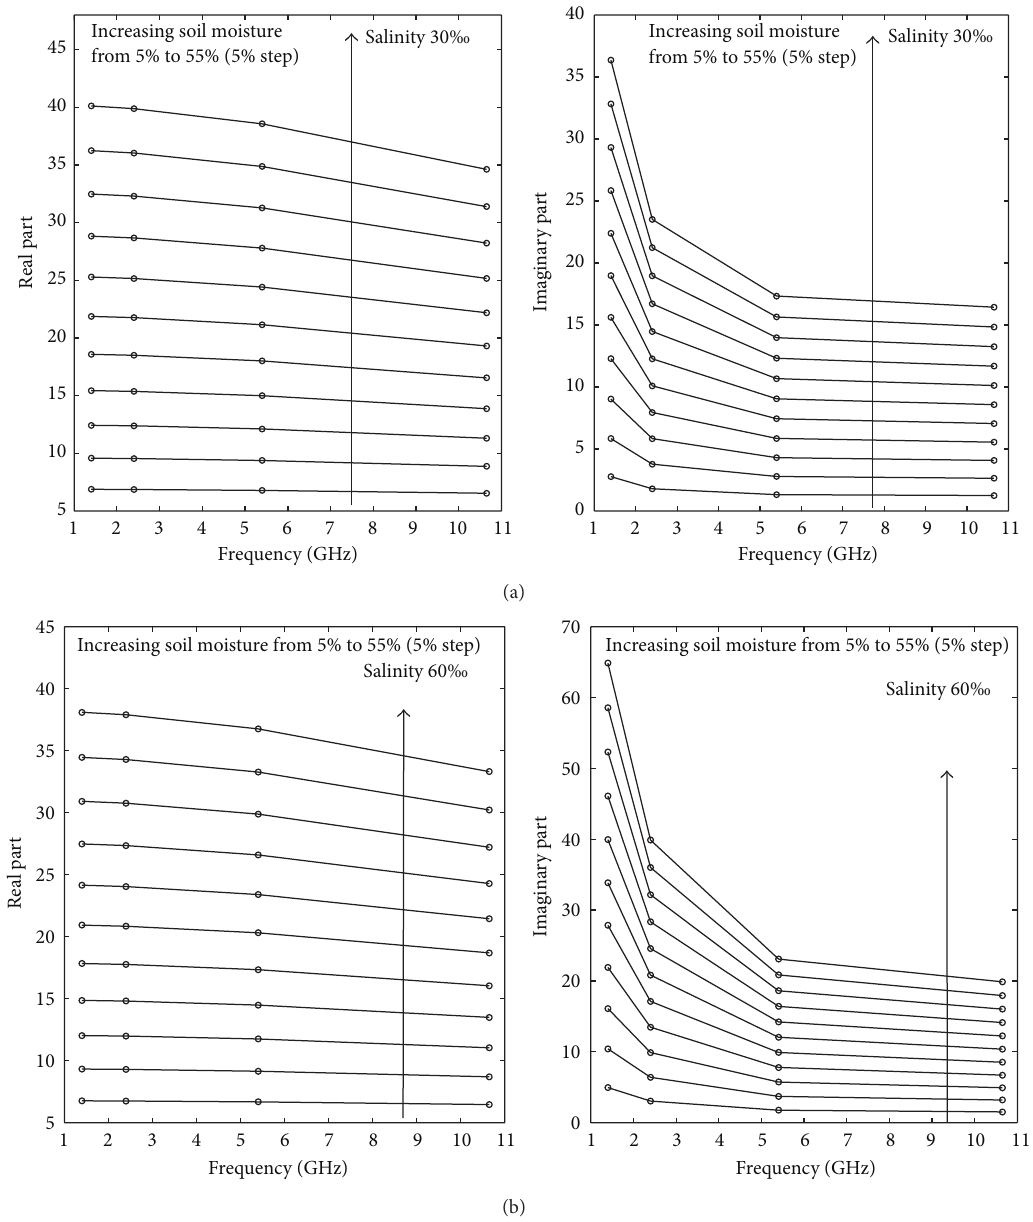
Figure 5: Effect of frequency on the dielectric constant at a salinity of 30 ‰ (a) and 60‰